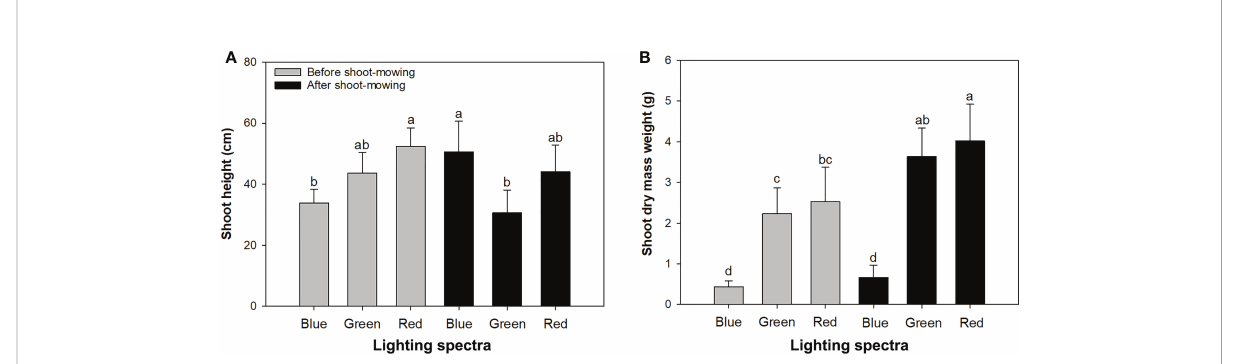
highest in mowed seedlings exposed to green light (Figure 3B). change of soluble sugars was not signi fi cant (Table 2).